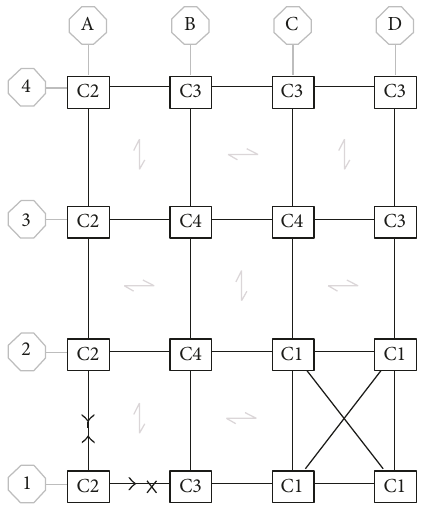
Figure 21: Typical plan view of RC columns.